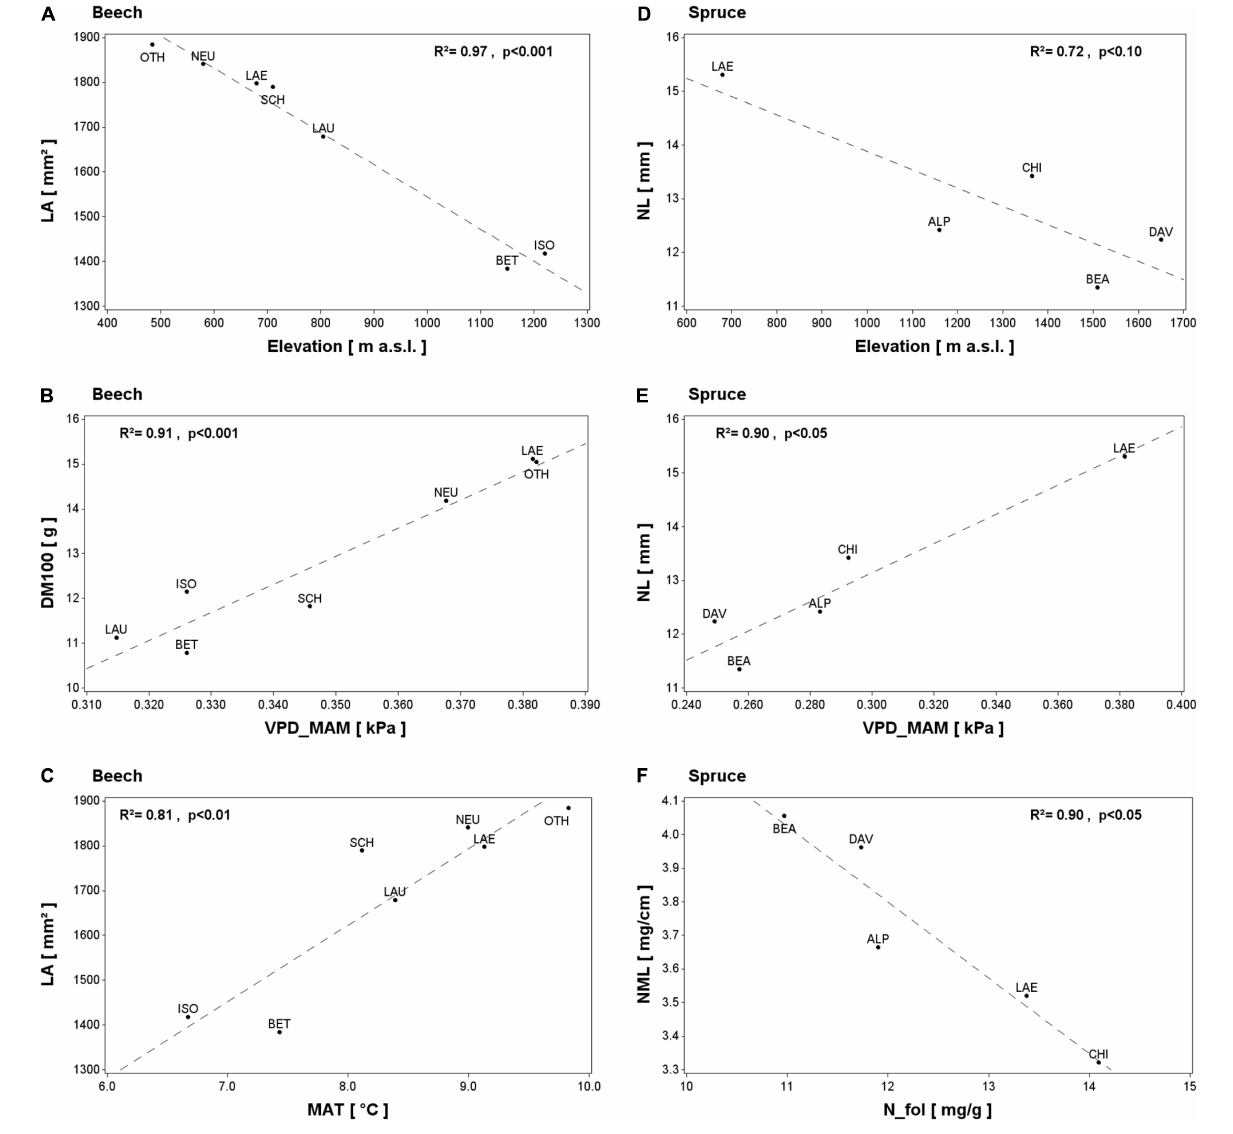
FIGURE 3 | Selected spatial relationships between leaf morphological traits in beech (A–C) and spruce (D–F) and independent variables: elevation (A,D) and long-term averages (1994–2019) of spring vapor pressure deficit (B,E) , mean annual temperature (C) and foliar N concentration (F) . The coefficient of determination ( R 2 ) and the P -value of the linear regressions are shown. Selection was based on species differences, results of temporal LMT variations, and the significance of the relationship. For abbreviations see Table 2